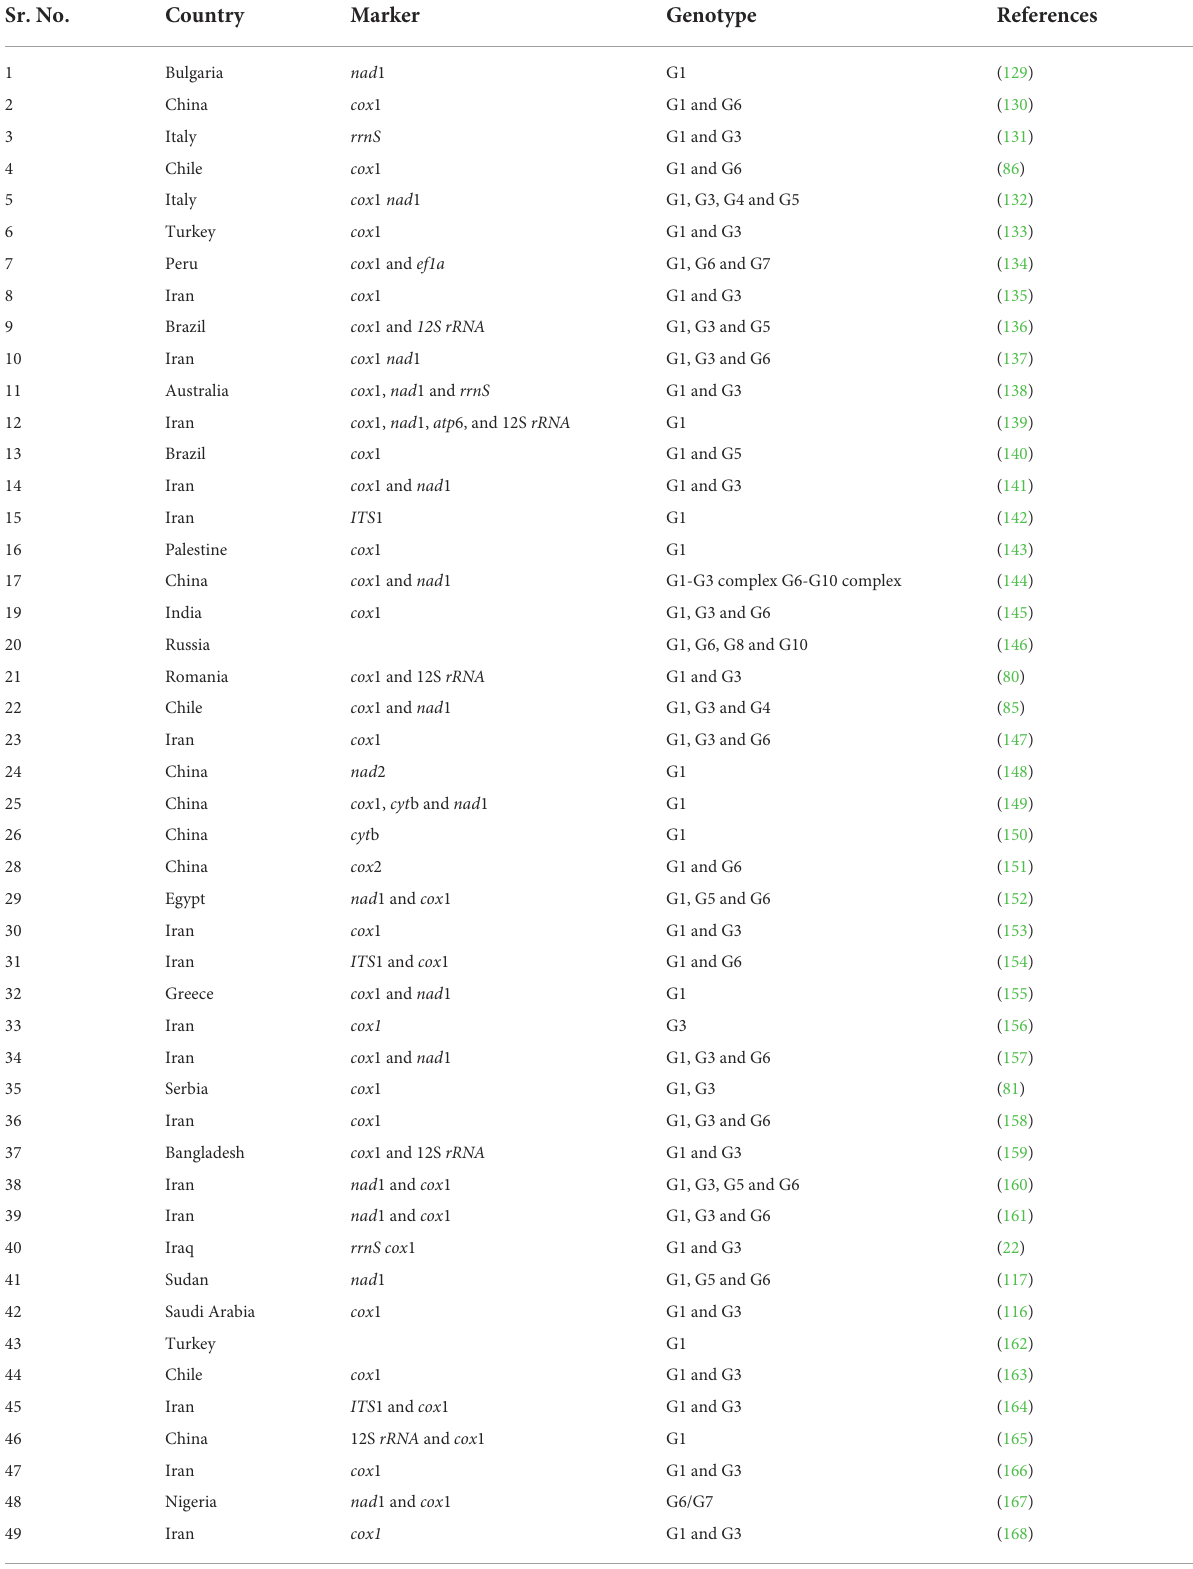
TABLE 1 Overview of prevalent genotypes of Echinococcus species and molecular markers that were investigated in different countries. Sr. No. Country Marker